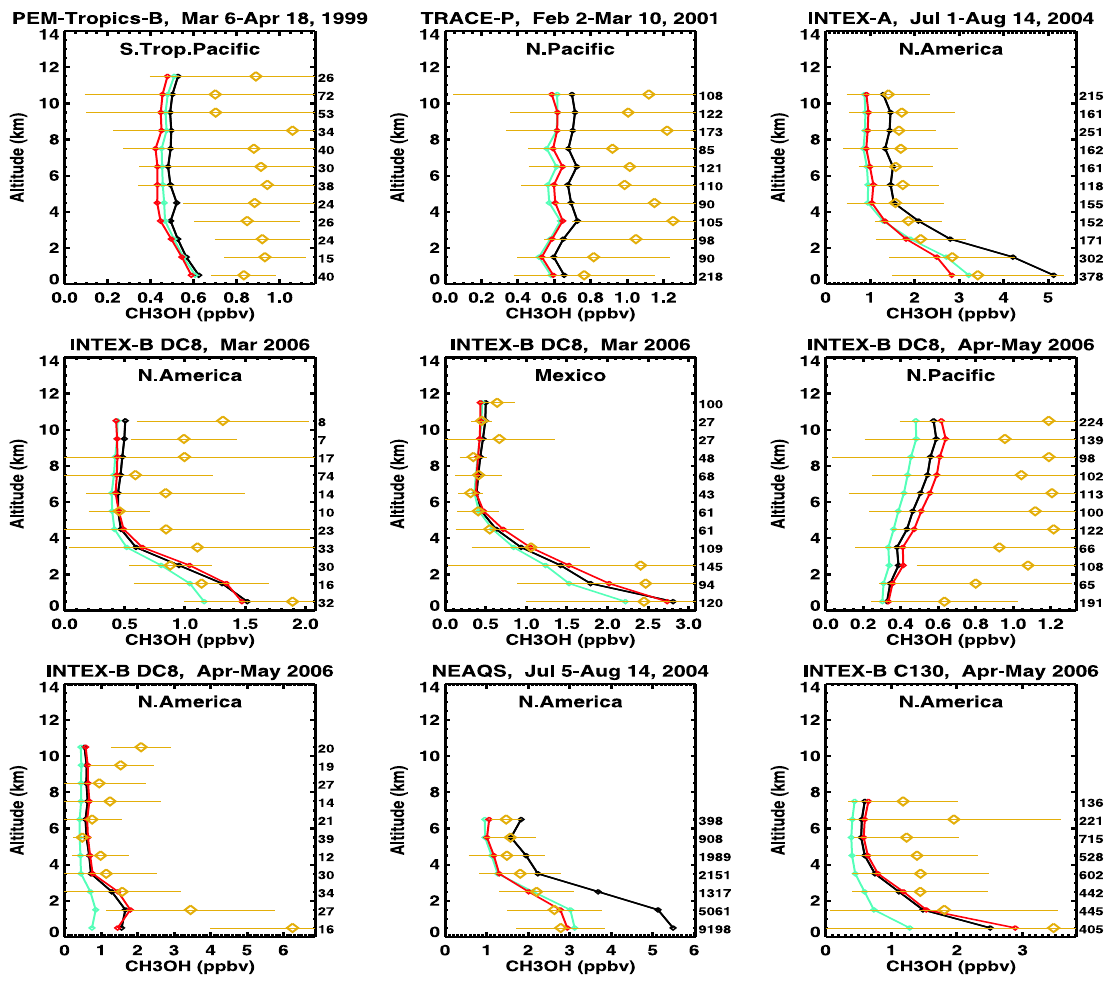
Fig. 7. Mean simulated (for 2009) and observed vertical distributions of methanol concentrations during the INTEX-A, NEAQS, INTEX-B, PEM-Tropics-B and TRACE-A aircraft campaigns. Regions are: North America (25–55 ◦ N, 45–130 ◦ W), Mexico (0–25 ◦ N, 85–110 ◦ W), N. Pacific (25–55 ◦ N, 160–230 ◦ E), South Tropical Pacific (0–40 ◦ S, 180–275 ◦ W). Colored curves correspond to the simulations of Table 1, black for S1, blue for S2, and red for the OptS2 inversion. The number of observations available at each altitude bin is given on the right end of each plot. Error bars are standard